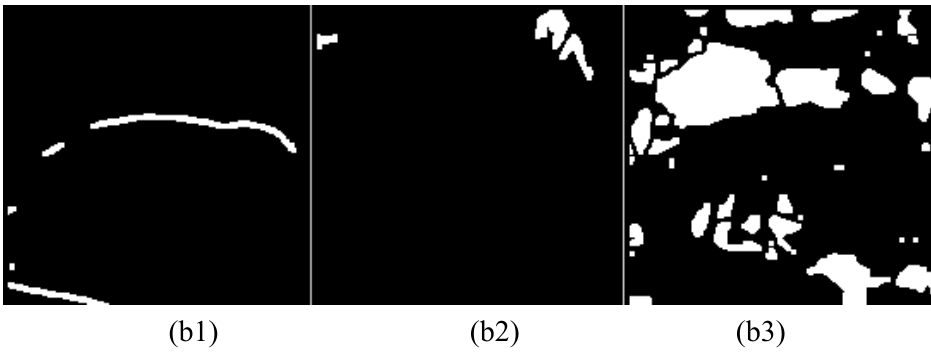
Figure 5. The post-processing result of Figure 3(d) and Figure 4(d): (a1) the “road” of Figure 3(d1); (a2) the “lake” of Figure 3(d3); (a3) the “terrain” of Figure 3(d2); (b1) the